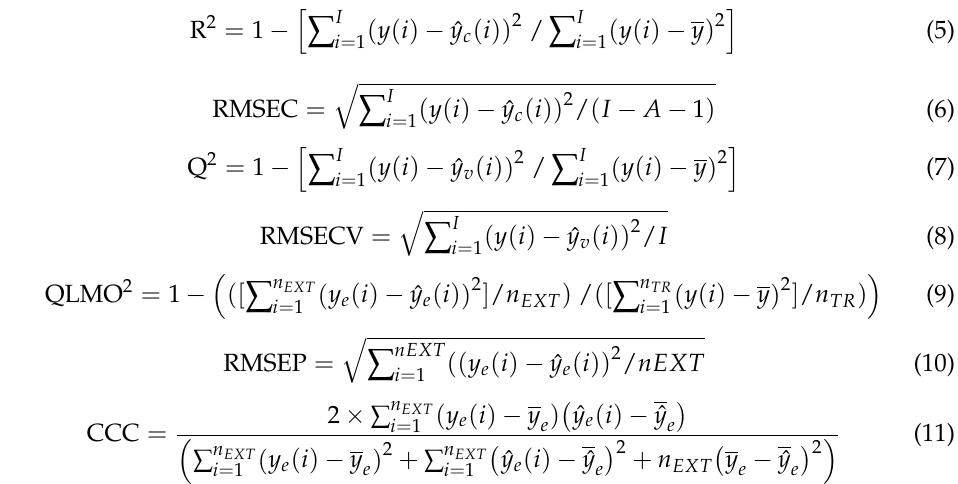
Table S3: Predicted clearance indices for the 15 bisphenols determined using three QSAR models based on either molecular descriptors, a combination of molecular and chromatographic descrip- tors or chromatographic descriptors. Table S4: Molecular descriptors significantly describing the chromatographic descriptors selected in QSAR models based either on chromatographic parameters alone or both chromatographic and